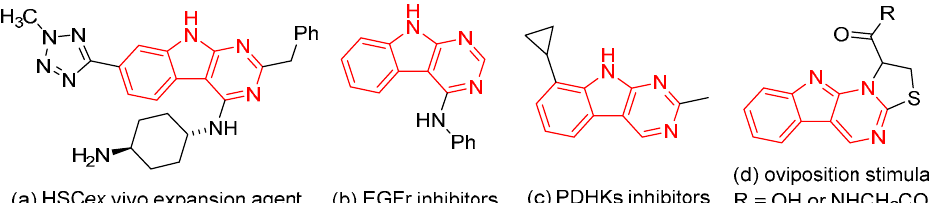
Figure 1. Representative biologically active 9 H -pyrimido[4,5- b ]indoles (( a ) [7], ( b ) [9], ( c ) [8], ( d )